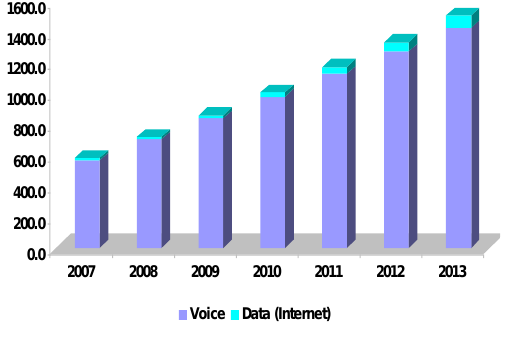
Figure 1: Growth in voice and data market